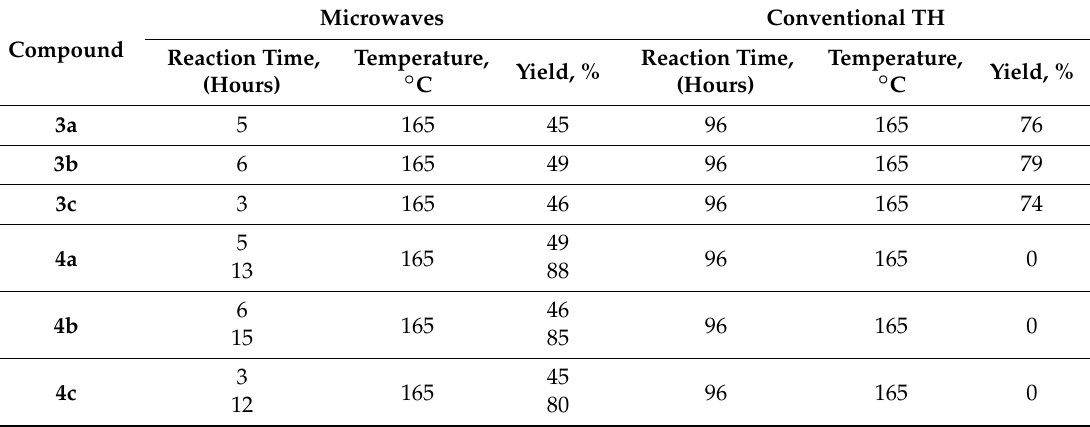
Table 1. The optimized conditions for synthesis of benzofuran derivatives ( 3a – c or/and 4a – c ), under MW and TH